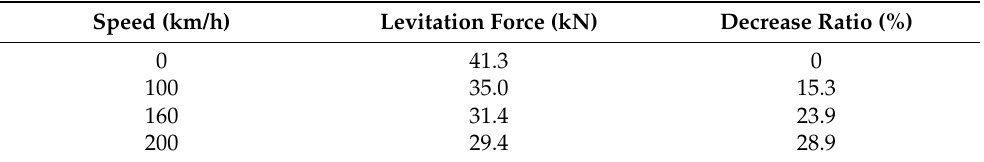
Table 2. The Calculated Levitation Force by AM. Speed (km/h) Levitation Force (kN) Decrease Ratio